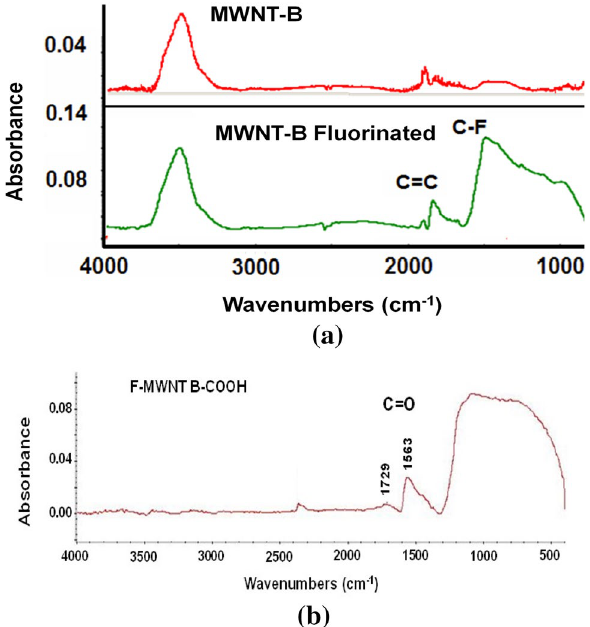
Fig. 4 FTIR spectra for MWNTs, MWNT B a before and after fluorina- tion and b after ethyl